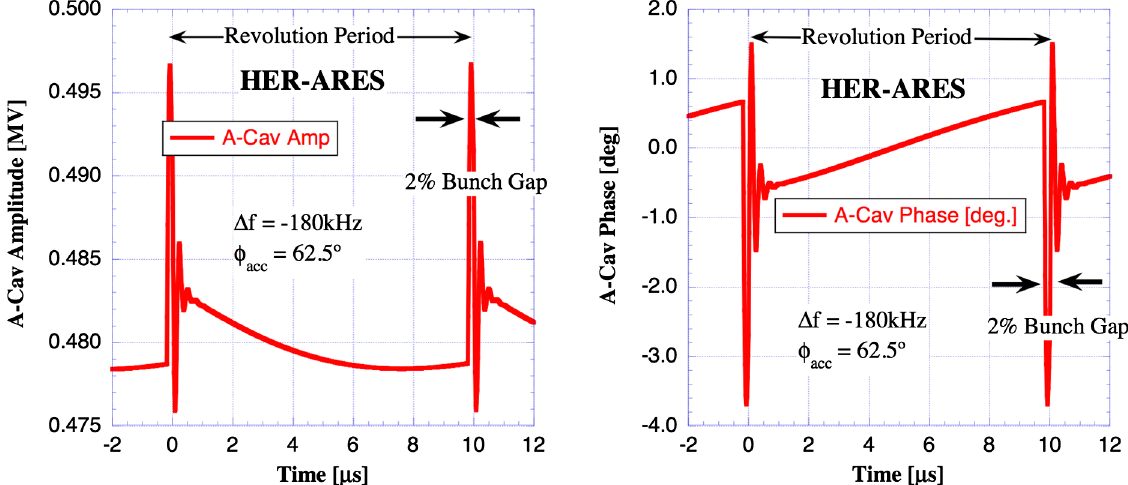
FIG. 9. ARES voltage (amplitude and phase) modulation simulated for HER in SuperKEKB.